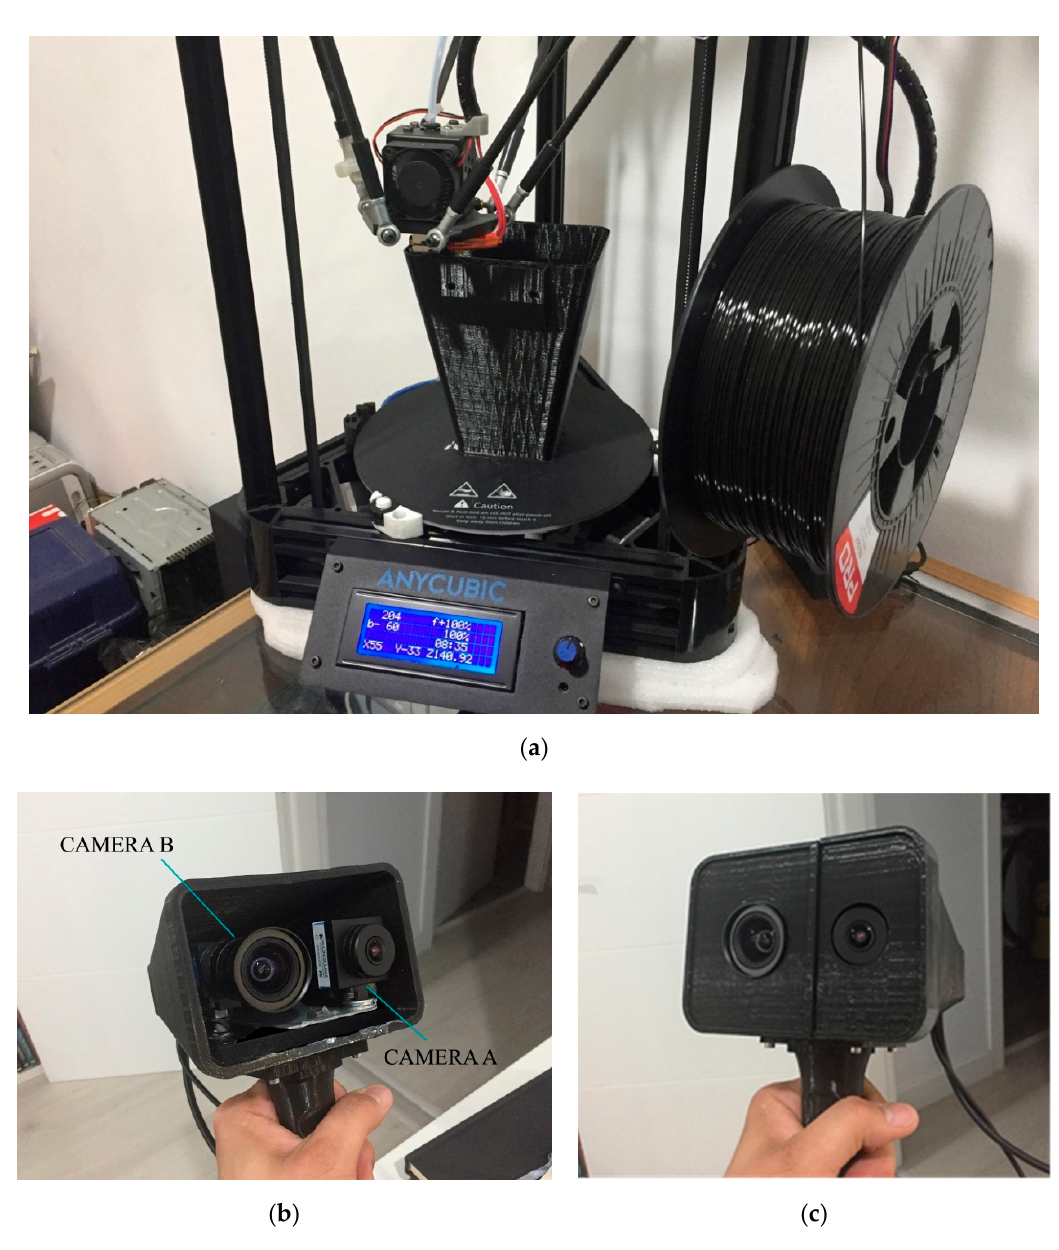
Figure 1. ( a ) 3D printing process of the prototype case; ( b ) cameras A and B with their placement inside the case; and ( c ) the final portable mobile mapping system prototype. Table 1. Main technical characteristics of cameras used in the prototype (from the Imaging Source Europe GmbH company).